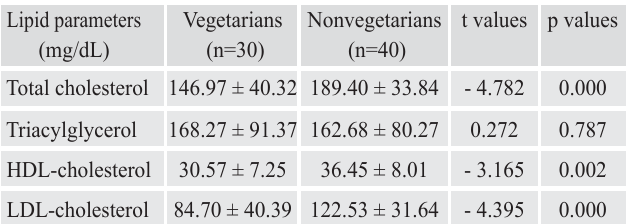
Table I: Comparison of serum lipid parameters between vegetarians and nonvegetatarian controls (N=70) Lipid parameters